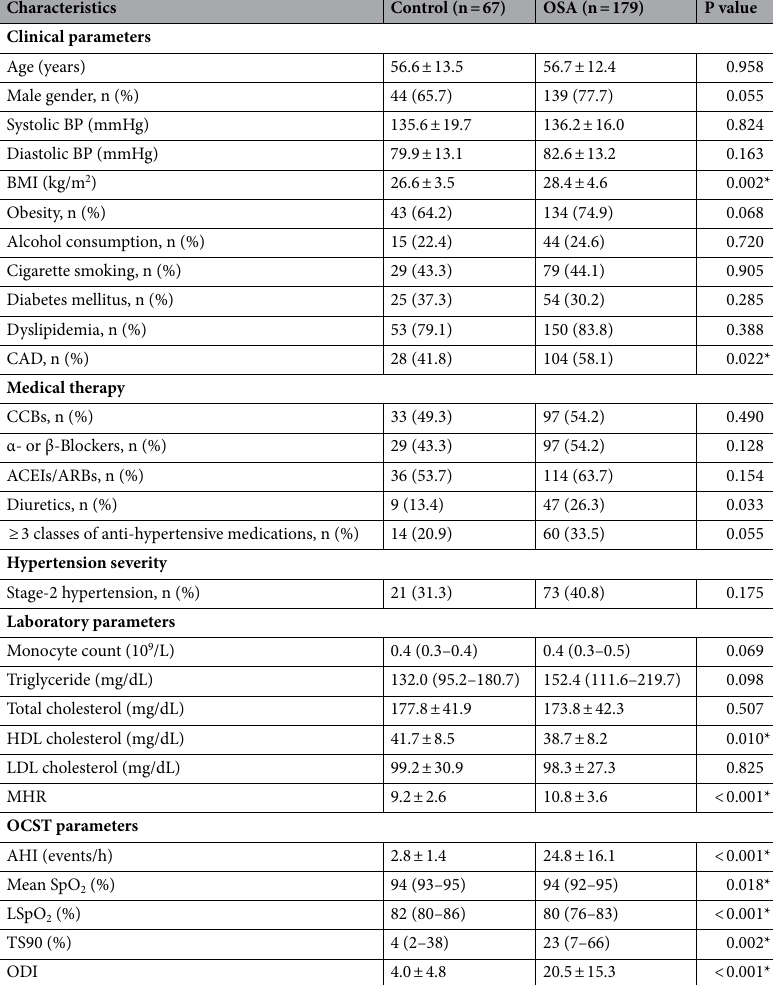
body mass index, CAD coronary artery disease, HDL high-density lipoprotein, LDL low-density lipoprotein, MHR monocyte to high-density lipoprotein cholesterol ratio, OCST out of center sleep testing, AHI